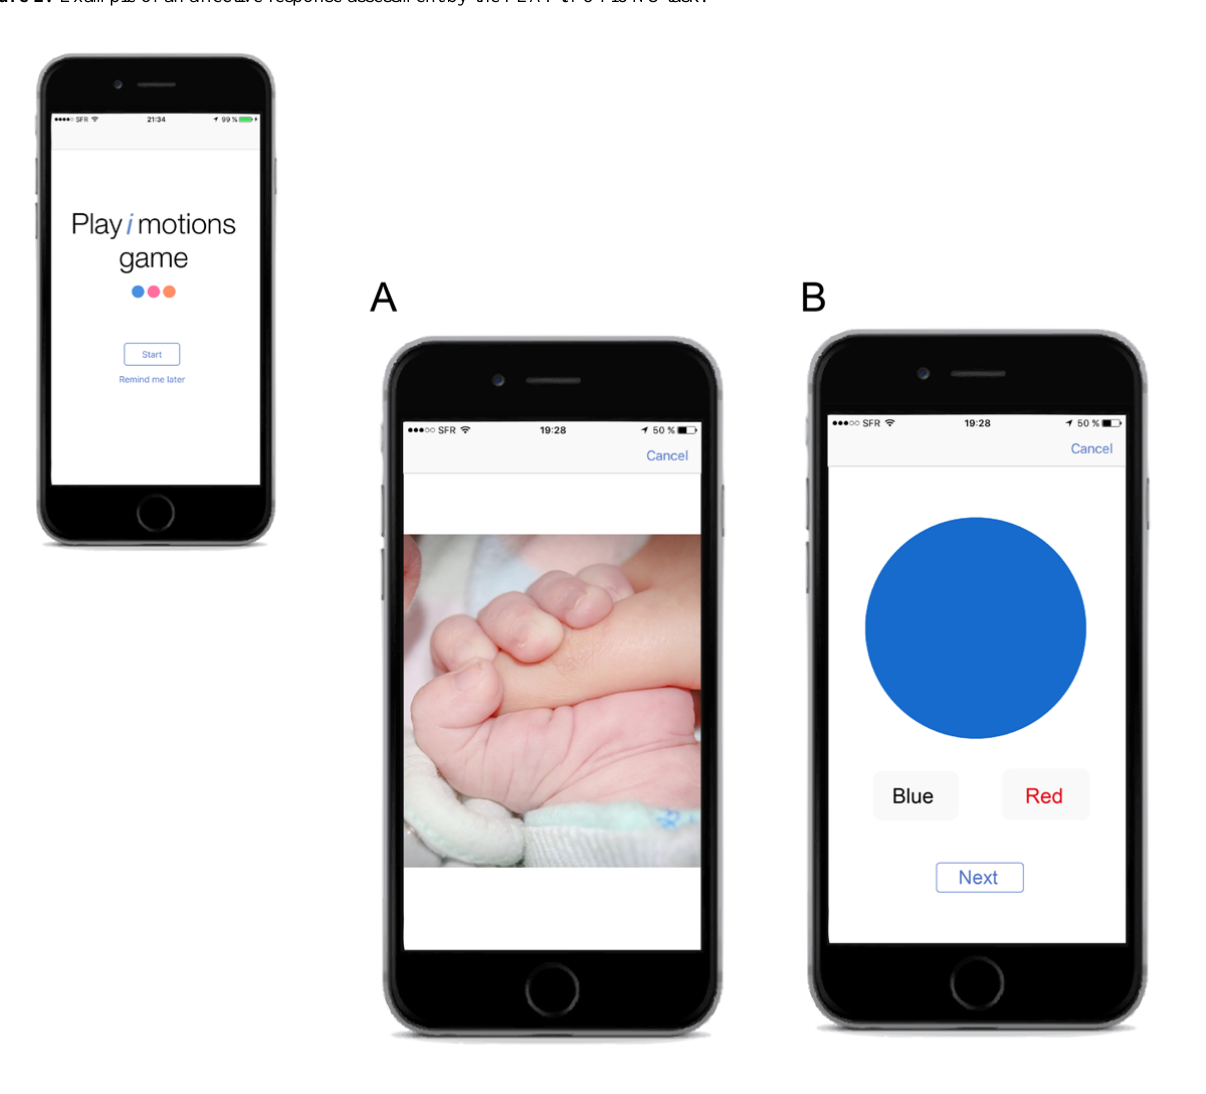
Figure 2. Example of an affective response assessment by the PLAY i MOTIONS